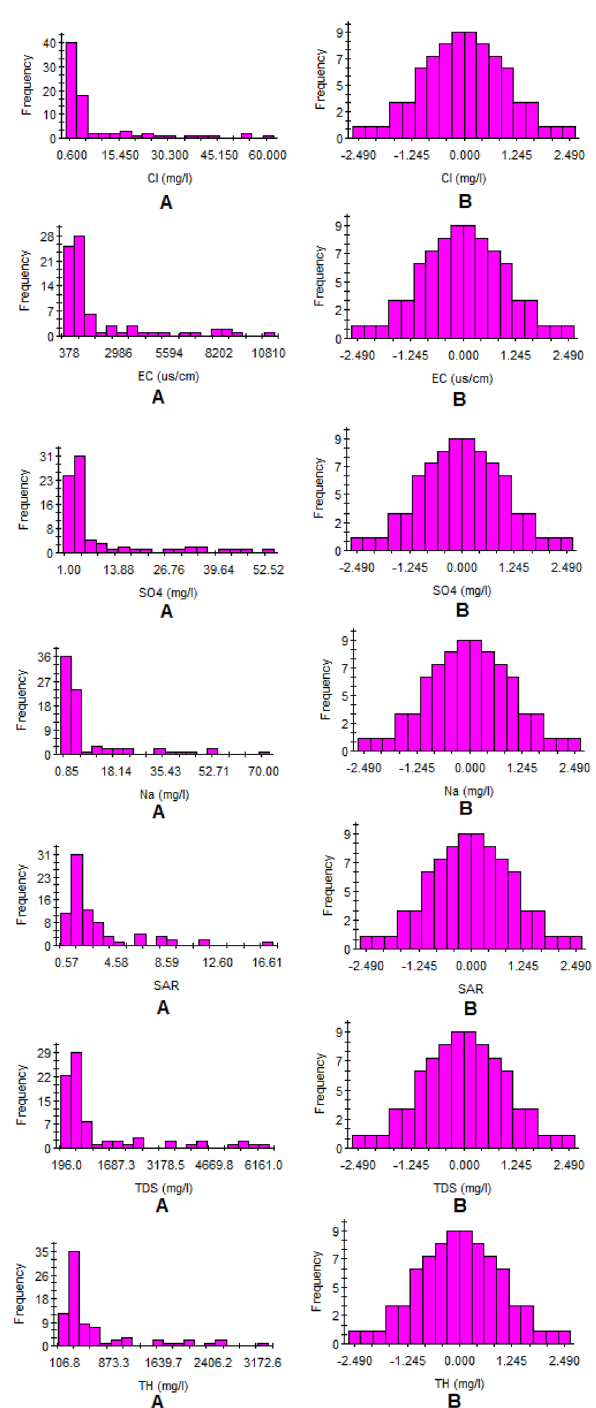
Fig. 8 Histograms of the frequency distribution: a before normaliza- tion, b after